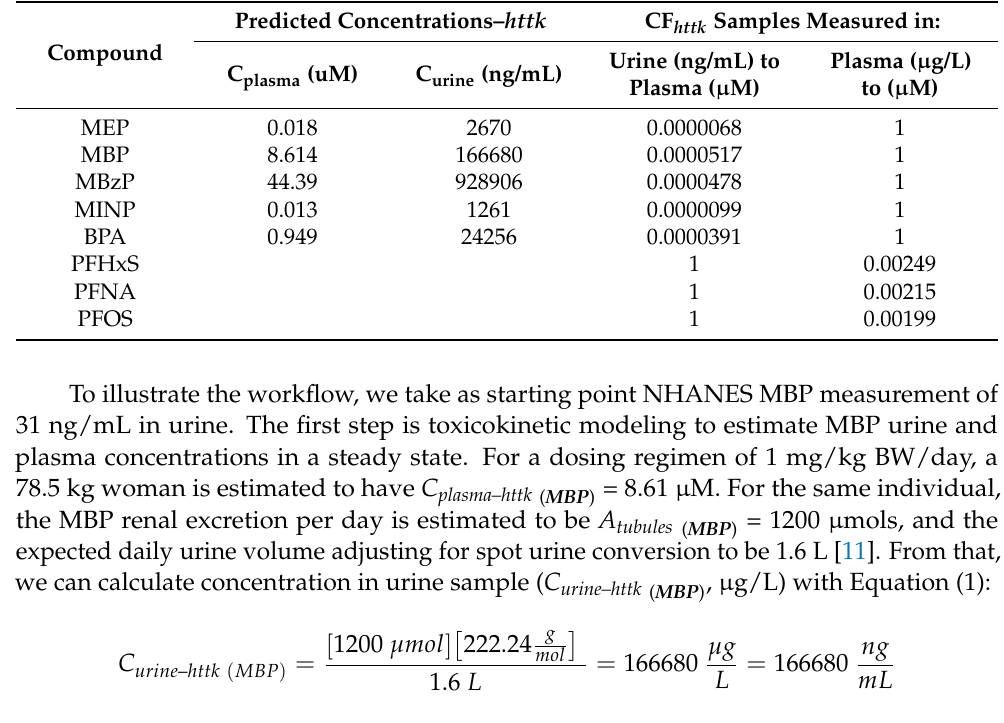
Table 3. Predicted urine and plasma concentrations ( µ M) of Mix N compounds for daily dose 1 mg/kg BW, and their ratios (i.e., CF httk ) to be used as conversion factors for urine to plasma concentrations for NHANES-derived